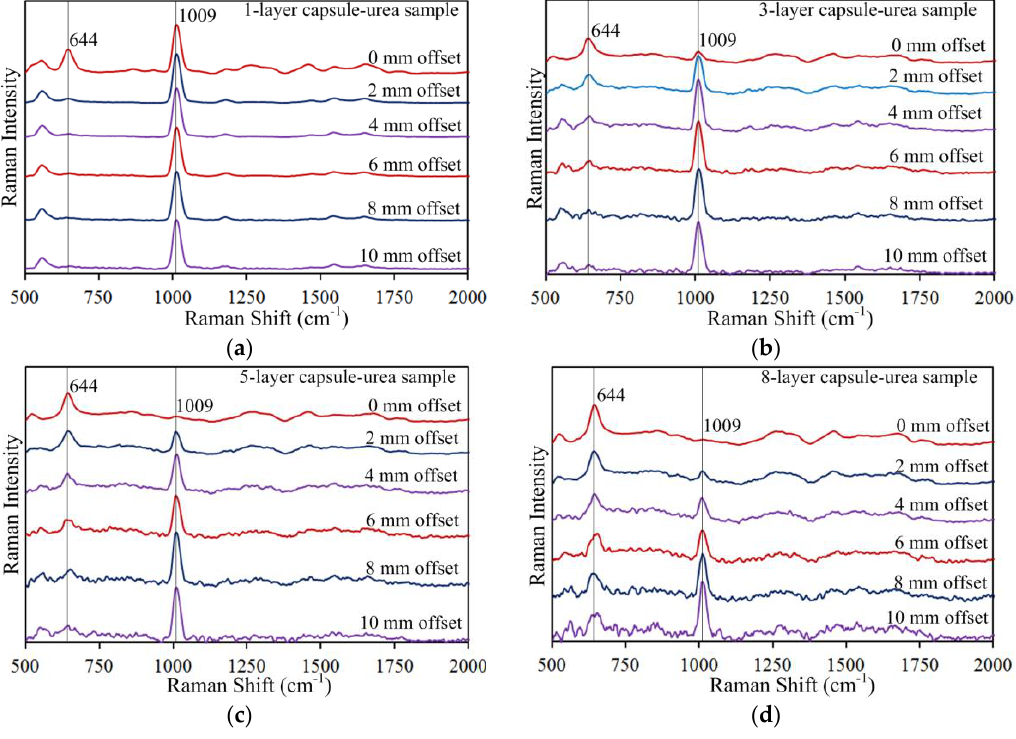
Figure 5. Spatially offset Raman spectra for ( a ) one-layer; ( b ) three-layer; ( c ) five-layer; and ( d ) eight-layer capsule-urea samples.